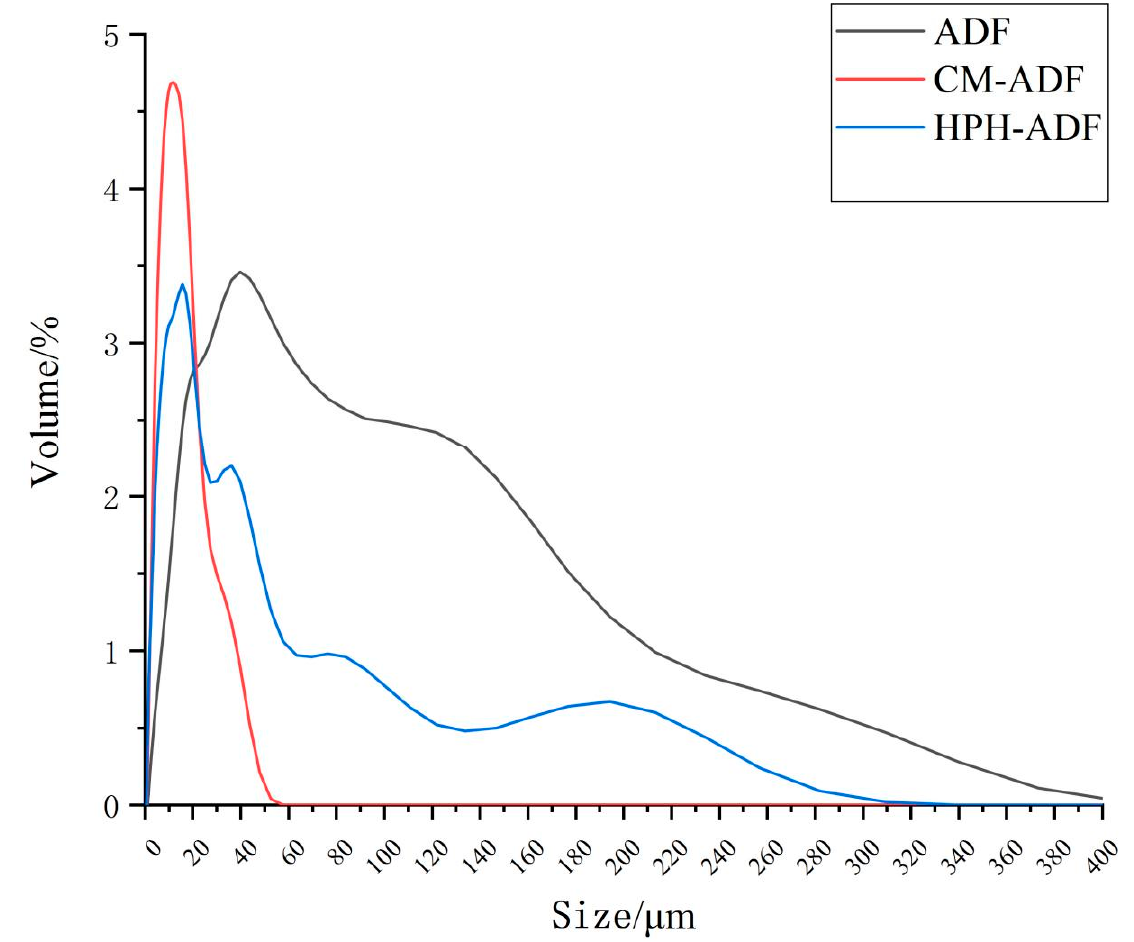
Figure 1. Particle size distribution of ADF, SP-ADF, HPH-ADF and CM-ADF. Table 2. Effect of modification on the content of